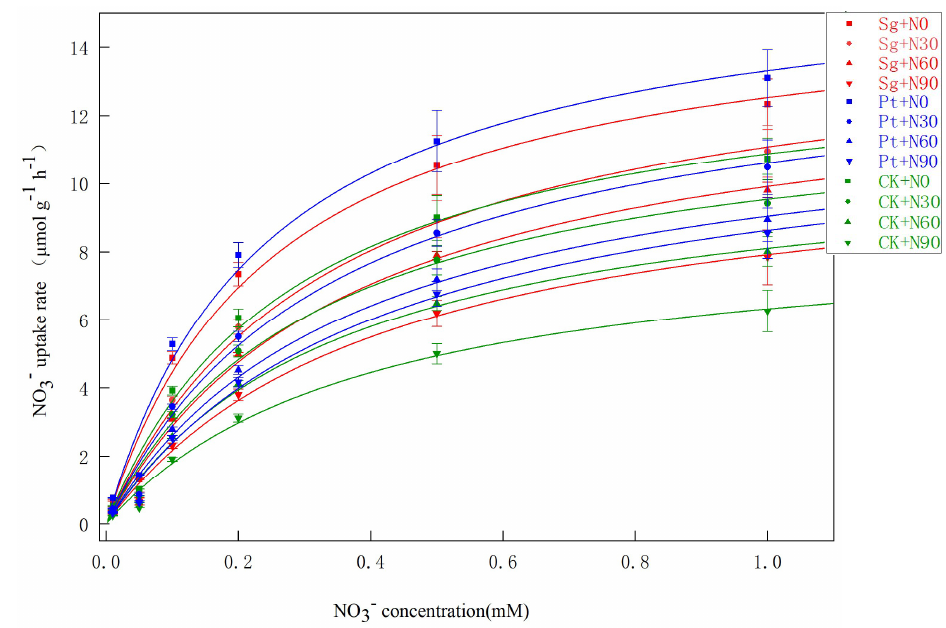
Figure 3. Uptake of NO 3 − by Pinus massoniana seedlings as a function of NO 3 − solution concentration. Note: Vertical bars illustrate standard errors of the means ( n = 3). CK: control. Sg: Suillus grevillei . Pt: Pisolithus tinctorius . N0: 0 kg·N·ha −1 a −1 . N30: normal deposition of 30 kg·N·ha −1 a −1 . N60: mod-